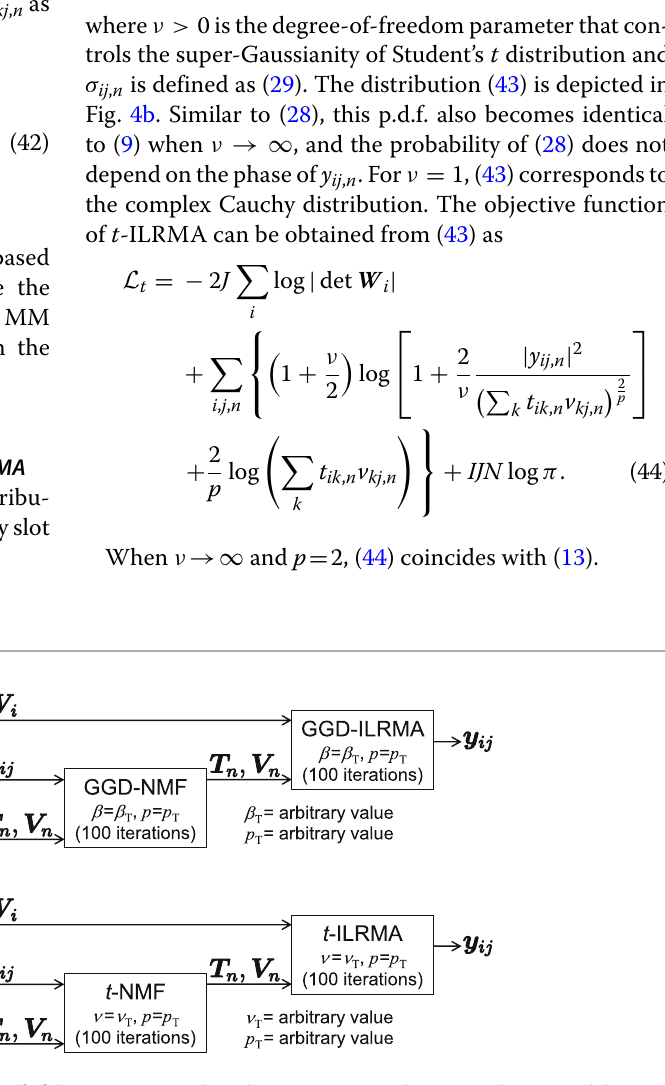
Fig. 15 Tempering approach for a GGD- and b t -ILRMA. The first half of the optimization is based on GGD-ILRMA with β = 2 and p = 1, and the second half is the proposed method with arbitrary parameters, where the NMF source model is retrained using the temporary estimated signal after the first-half